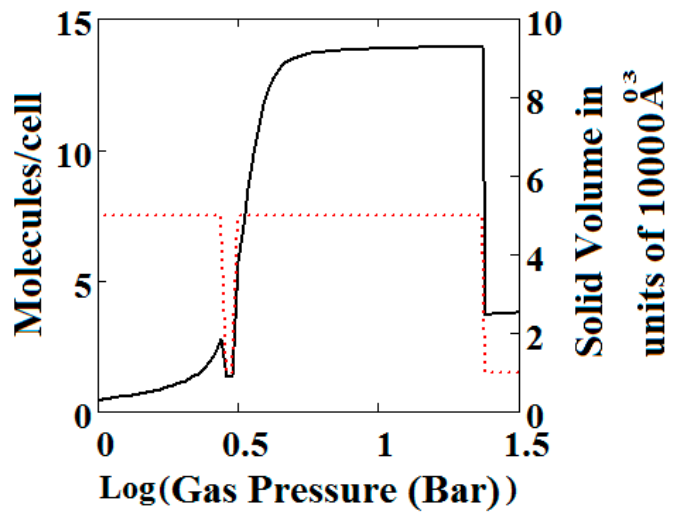
Figure 4. Methane adsorption in the theory MOF showing two regions of NGA. The dotted red curve on the secondary right axis indicates the NP/LP state of the MOF. The other parameters are T = 285 K, uglp = 29.1 kJ/mole, ugnp = 28.69 kJ/mole, J = 1.66 kJ/mole, ∆ = 5.8 kJ/mole, X = 10,000 Å 3 , Y = 50,000 Å 3 . At high gas pressure the MOF is compressed into the NP state. The behaviour shown at high pressure should be almost universal for MOFs. Nm = 10, scale = 0.85, nmaxlp = 4, nmaxnpb = 4 (sharp transformation theory).